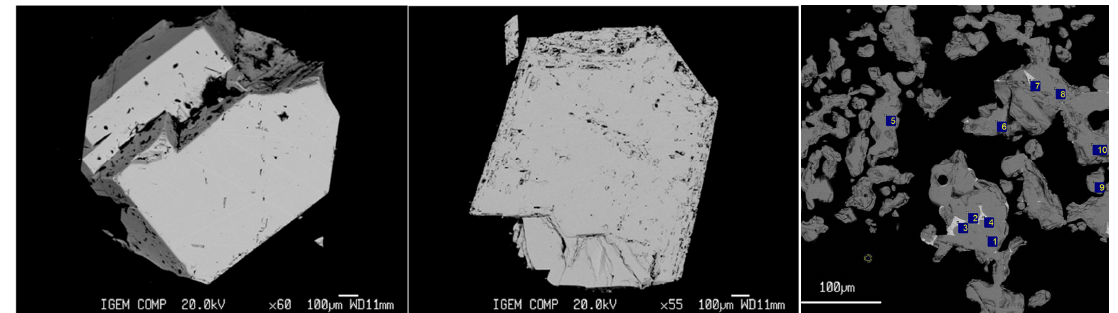
Figure 1. Back-scattered electron images of sphalerite crystals synthesized in the Zn–Ag–(In)–S system. Samples 4152, 4169—gas transport synthesis, Sample 4197—dry synthesis. Several inclusions of Ag 2 S (light-grey) are seen in the image of Sample 4197; numbers indicate points of analysis.